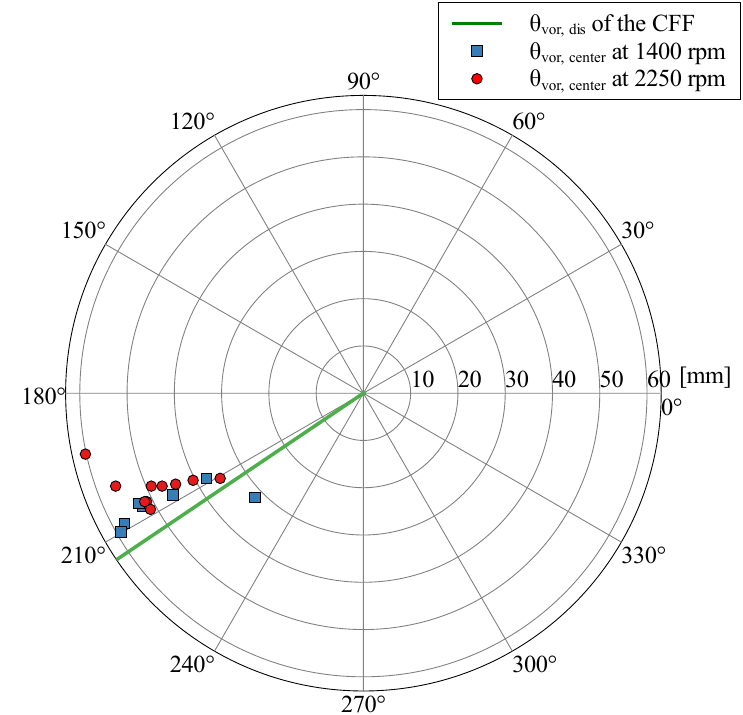
Figure 23. The vortex center position for different flow rates.